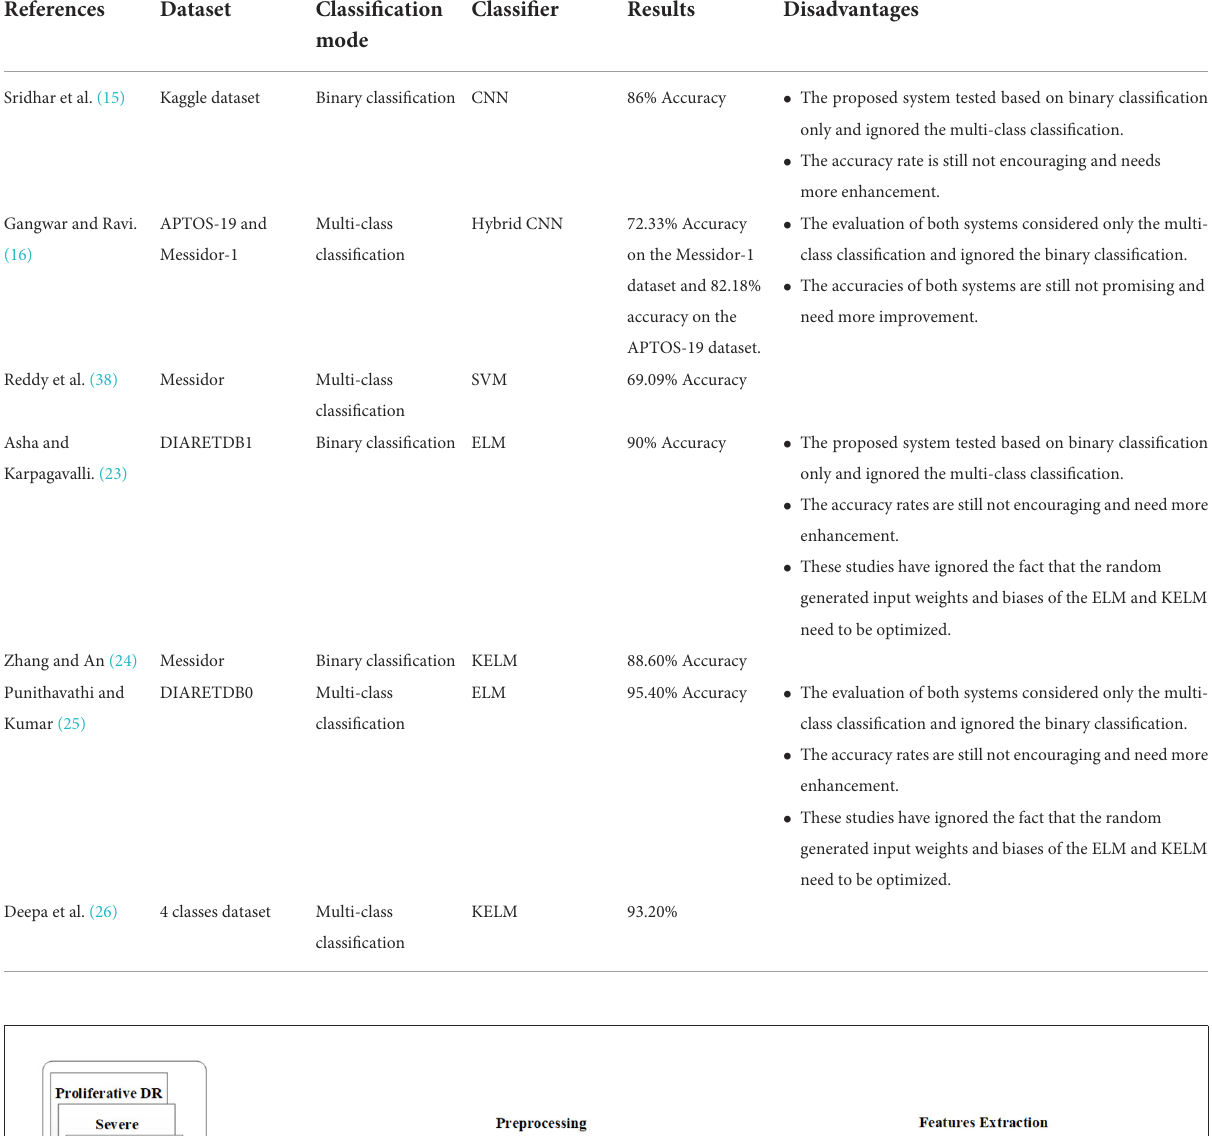
TABLE 1 Illustrates the previous works of DR detection using ML and deep learning techniques.